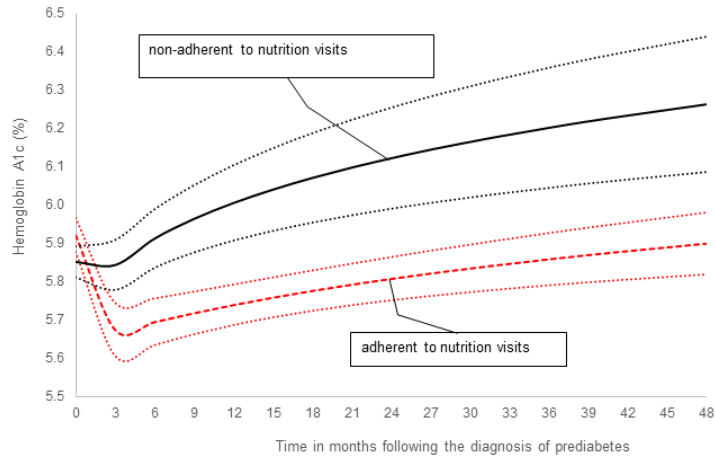
( p = 0.01) after adjusting for confounders.